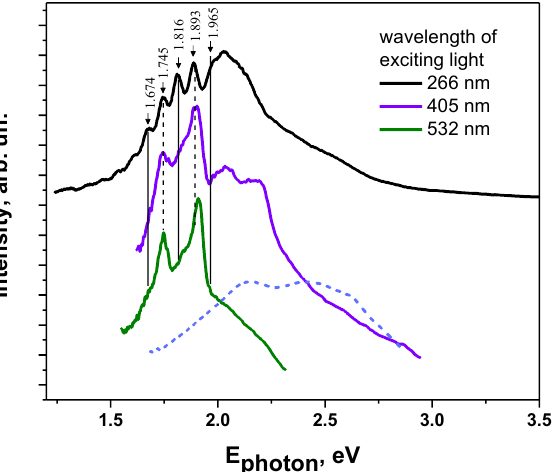
Figure 9. Photoluminescence spectra of MBI-perchlorate crystals (Sample 3) under photoexcitation with λ ex = 266 nm, 405 nm, and 532 nm. The dotted line represents the emission spectrum of aqueous solution of brown MBI-perchlorate crystal under 405 nm excitation. The spectra are shifted along the vertical axis for the convenience of readers.